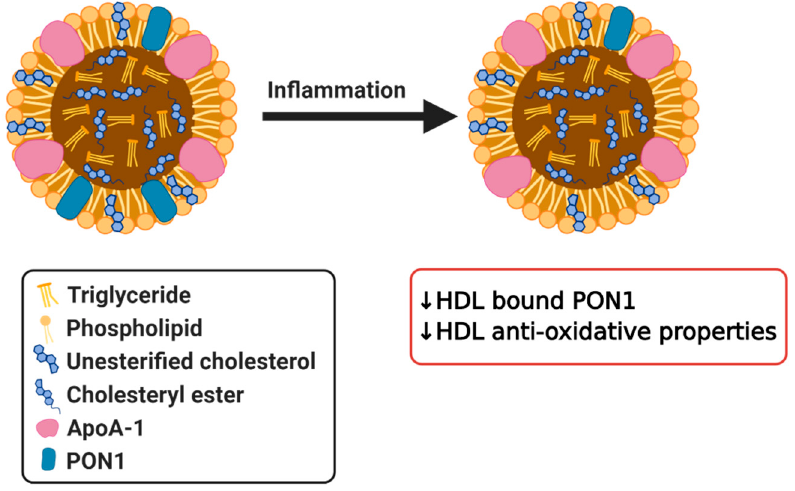
Figure 4. Simplified diagram of effects of inflammation on HDL bound paraoxonase 1 (PON1) resulting in dysfunctional HDL.